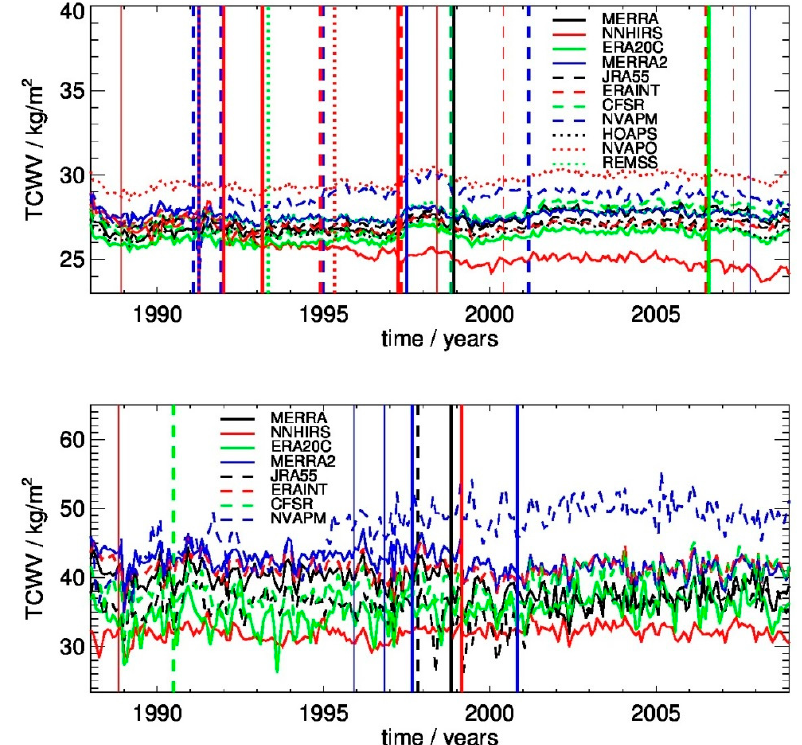
Figure 3. Time series of TCWV anomalies, averaged over the global ice-free ocean within 60 ◦ N/S ( top ) and over central Africa ( bottom , as marked in Figure 2). Each anomaly time series has been shifted by the mean TCWV of the corresponding TCWV time series. The vertical lines mark observed break points using the color code from the anomalies. The vertical line is plotted in bold if the break point was detected by the PMF and SNH tests. The total numbers of observed break points from the PMF test are 27 (global ice-free ocean) and 9 (central Africa). The confirmed numbers of break points are 21 (global ice-free ocean) and 6 (central Africa). Table 3. Dates of confirmed break points and break sizes from the PMF and the SNH test for the region Sahara and for five additional regions which are shown in the figure to the lower right. The results are based on the analysis of TCWV anomaly differences relative to ERA-Interim. Printed in bold and green are break points that are observed over Sahara and its three subregions and printed in italic and green are break points over the Atlantic which are different from the break points over Sahara. The figure is a zoom into the right panel of Figure 2. Marked in red is the region Sahara and marked in black are the five subregions: Sahara 1, Sahara 2, Sahara 3, Coast and Atlantic (from east to west). Each subregion has identical width and length in degrees latitude and longitude.